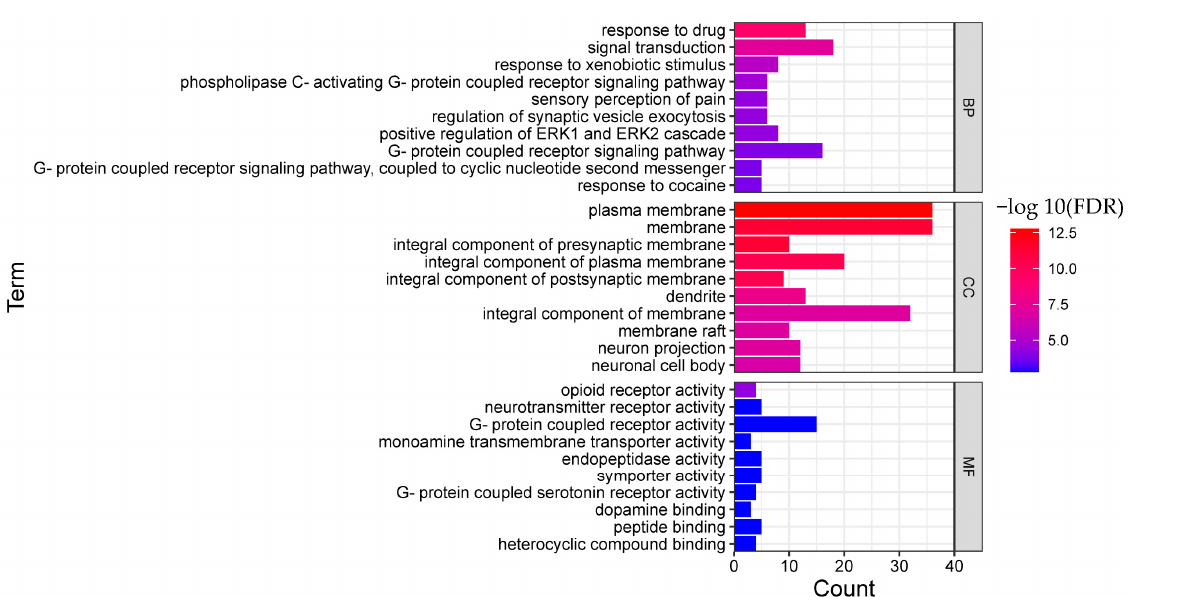
Figure 4. Functional enrichment analysis result of BRU (TOP 10; BP, biological process; CC, cellular component; MF, molecular function).